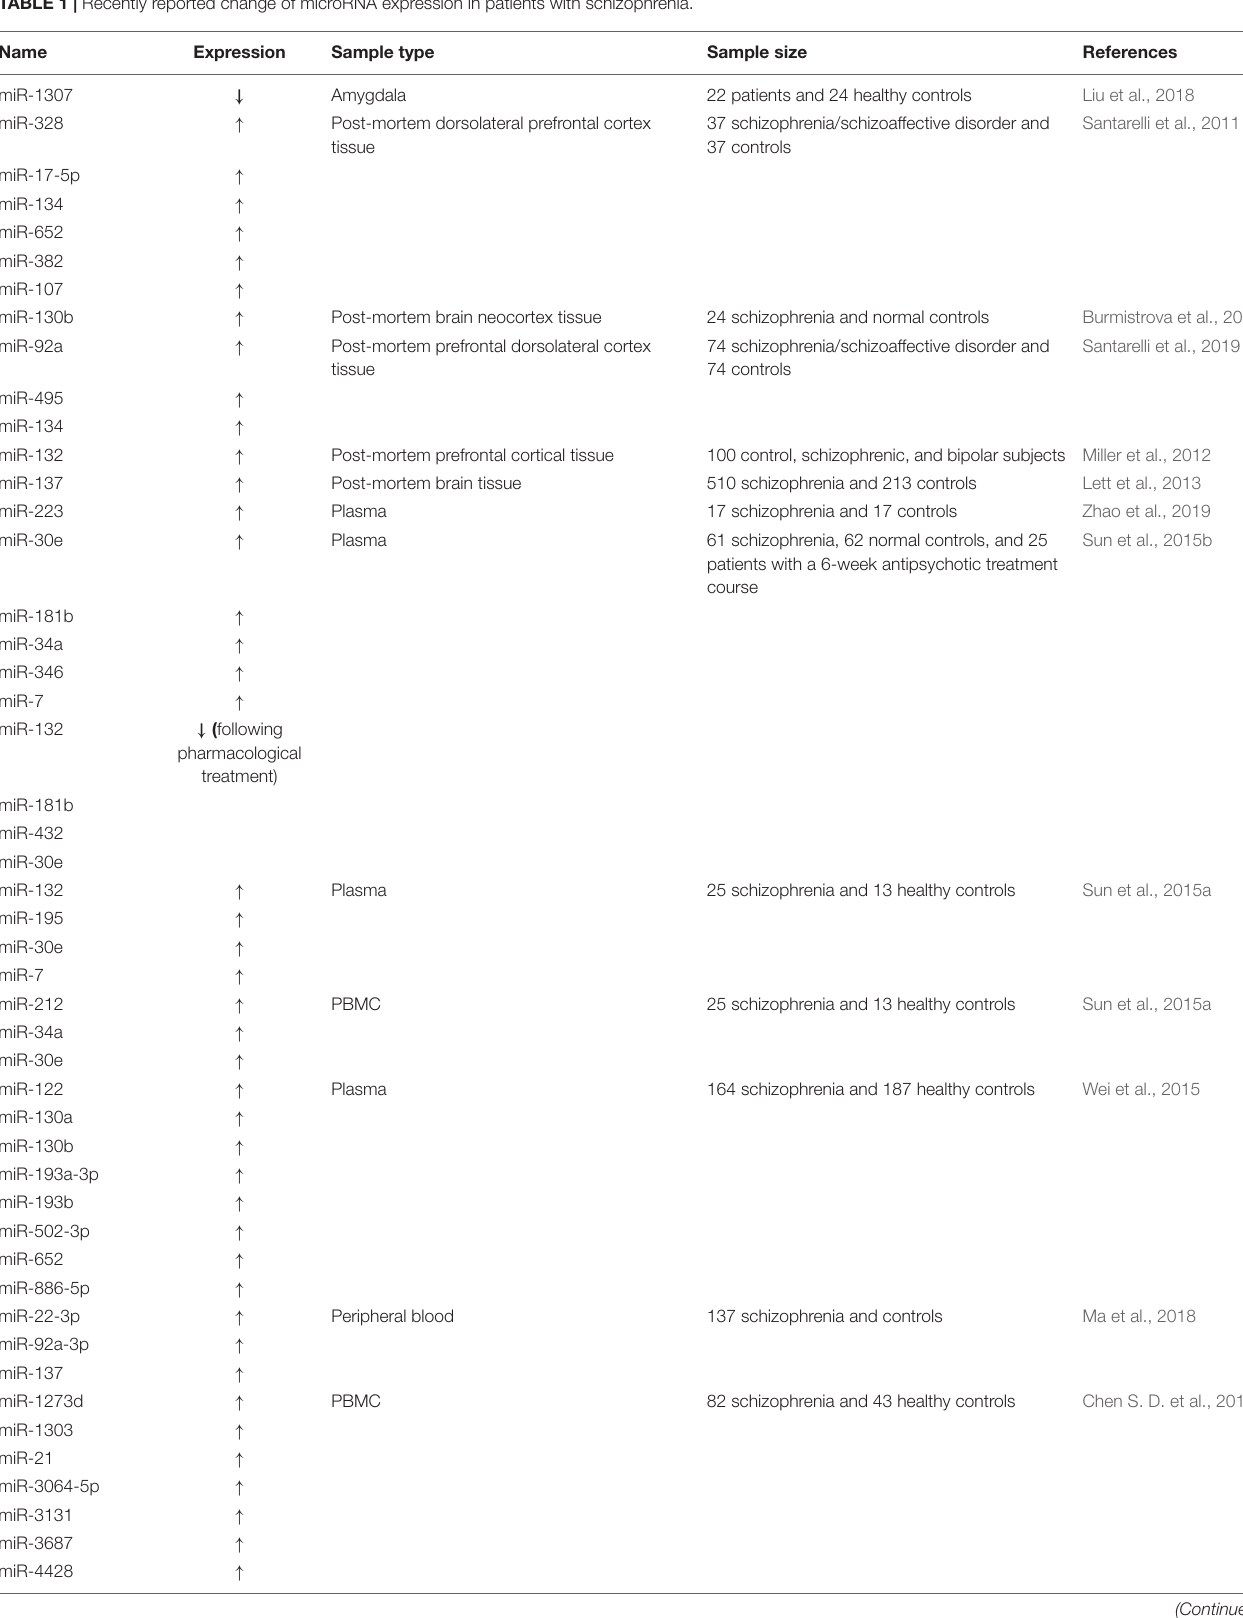
TABLE 1 | Recently reported change of microRNA expression in patients with